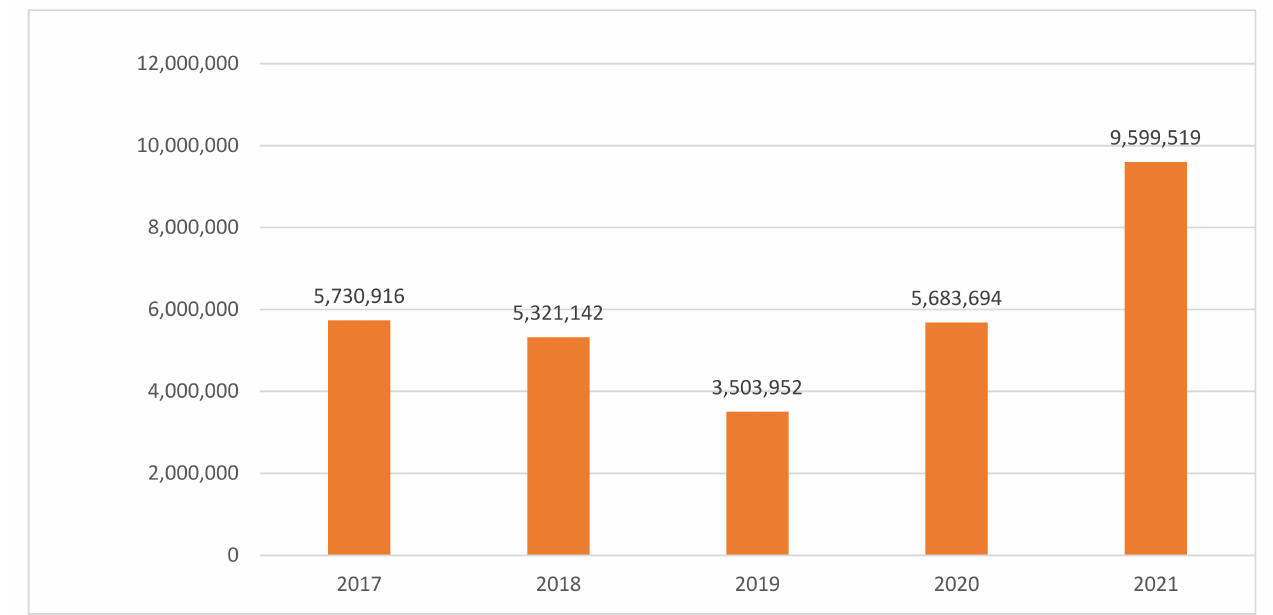
Figure 1. Malware installation packages for smartphone